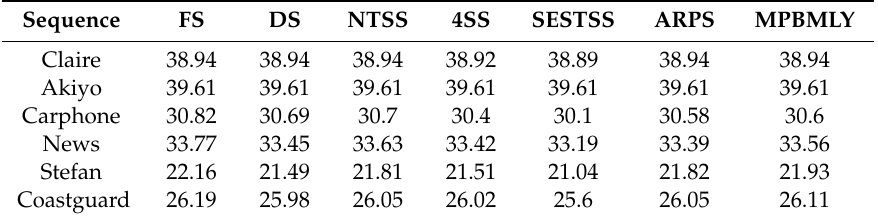
Table 8. Mean PSNR for 50